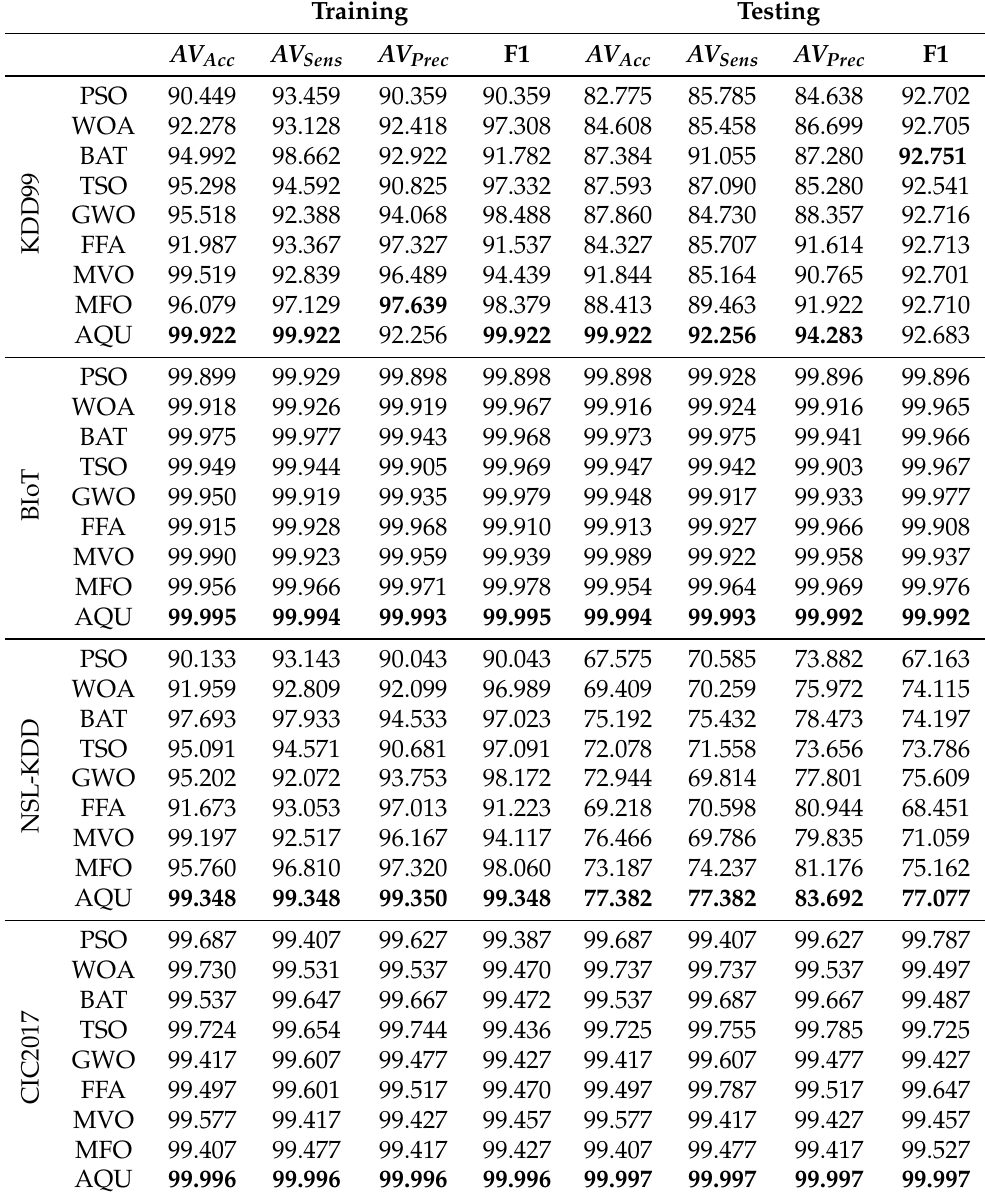
Table 3. Results of developed AQUa for the datasets in case of